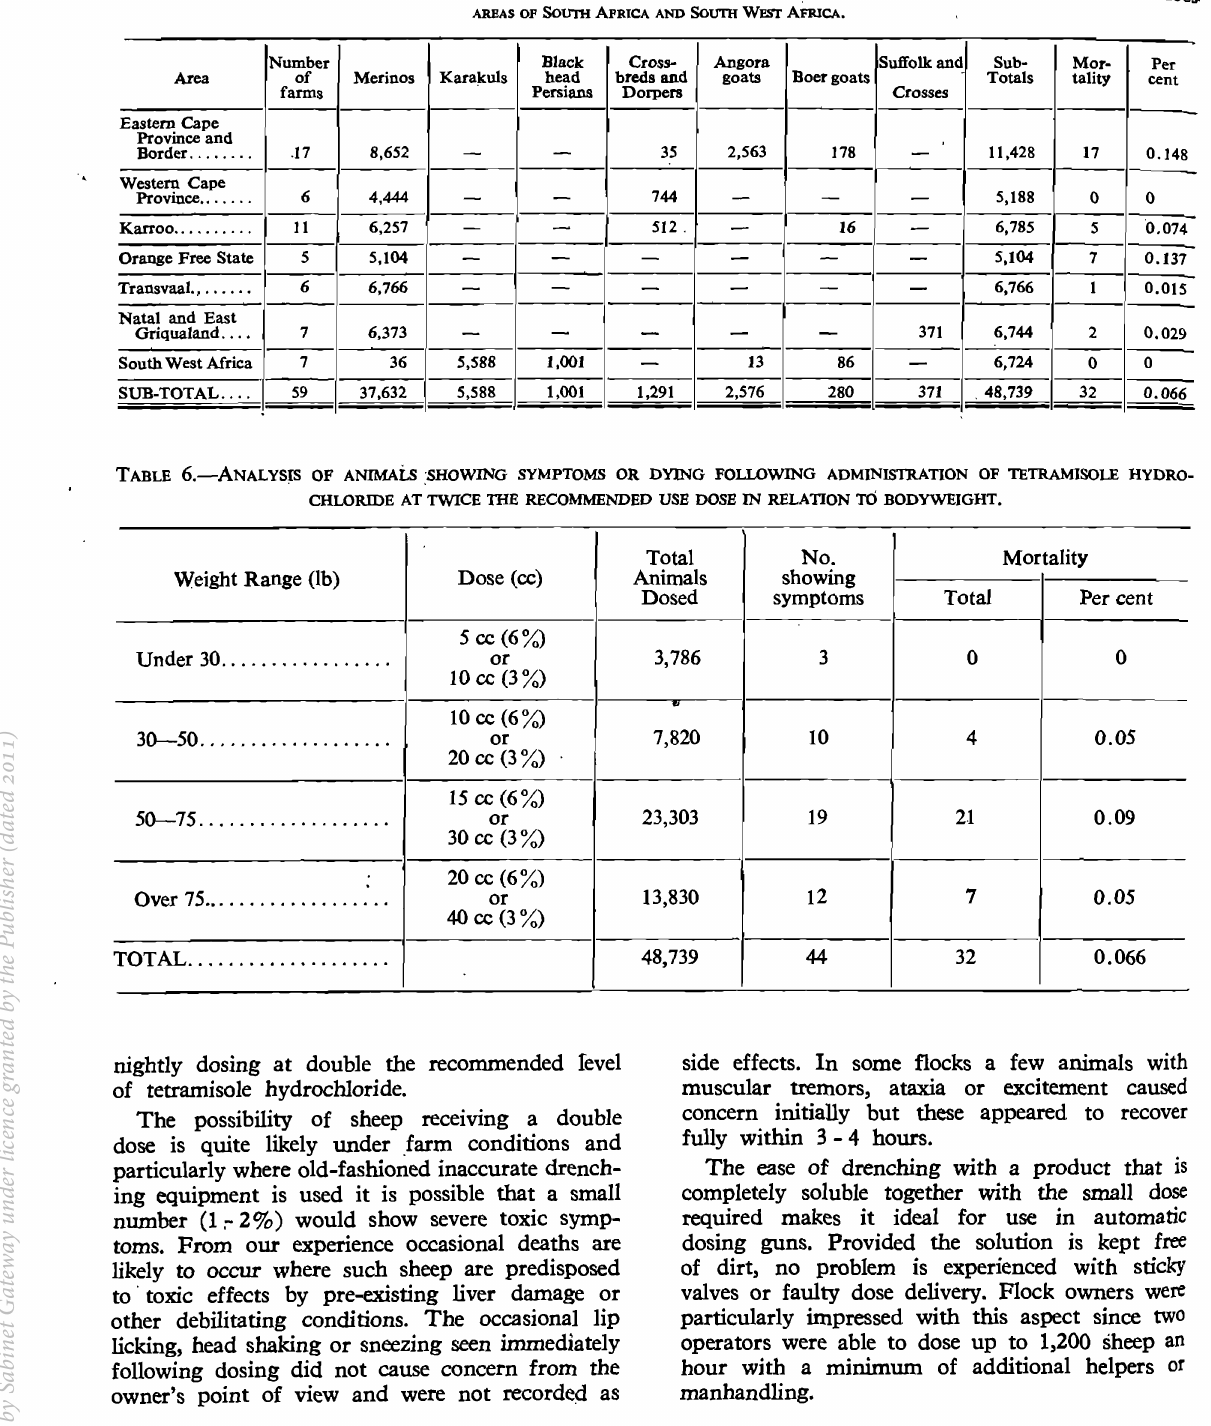
Number Black Cross-